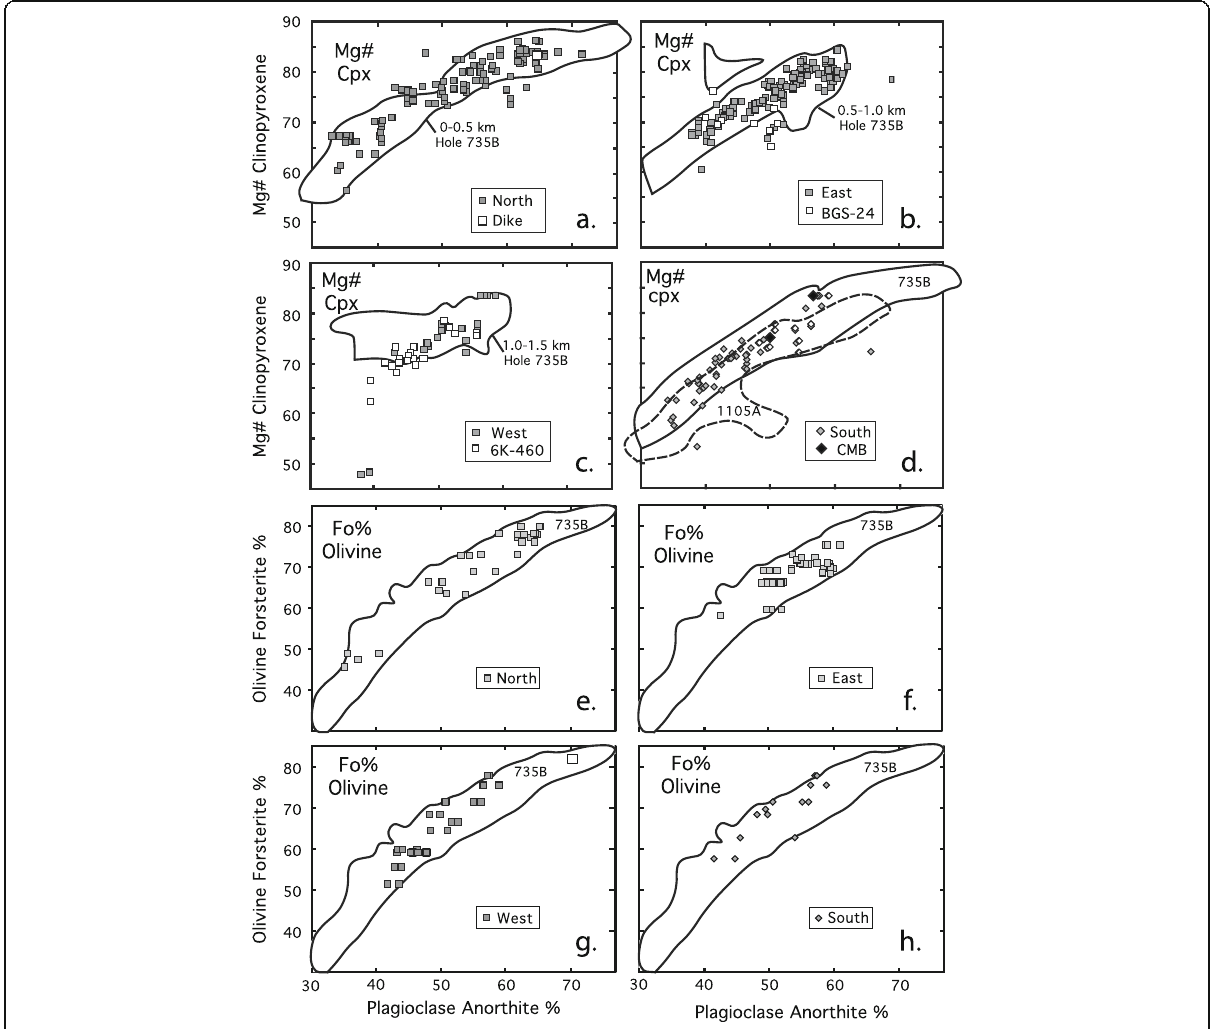
Fig. 17 a – d The composition of coexisting Pl and Cpx for the Atlantis Bank seafloor gabbros plotted by region as discussed in the text. The fields for Hole 735B gabbros for 0 – 0.5 km, 0.5 – 1.0 km, and 1 – 1.5 km are shown for reference in panels a , b , and c (Dick et al. 2001). d 0 – 1.5 km Hole 735B field and field for Hole 1105A (Thy et al. 2003). e – h The composition of coexisting plagioclase and olivine by region with field for Hole